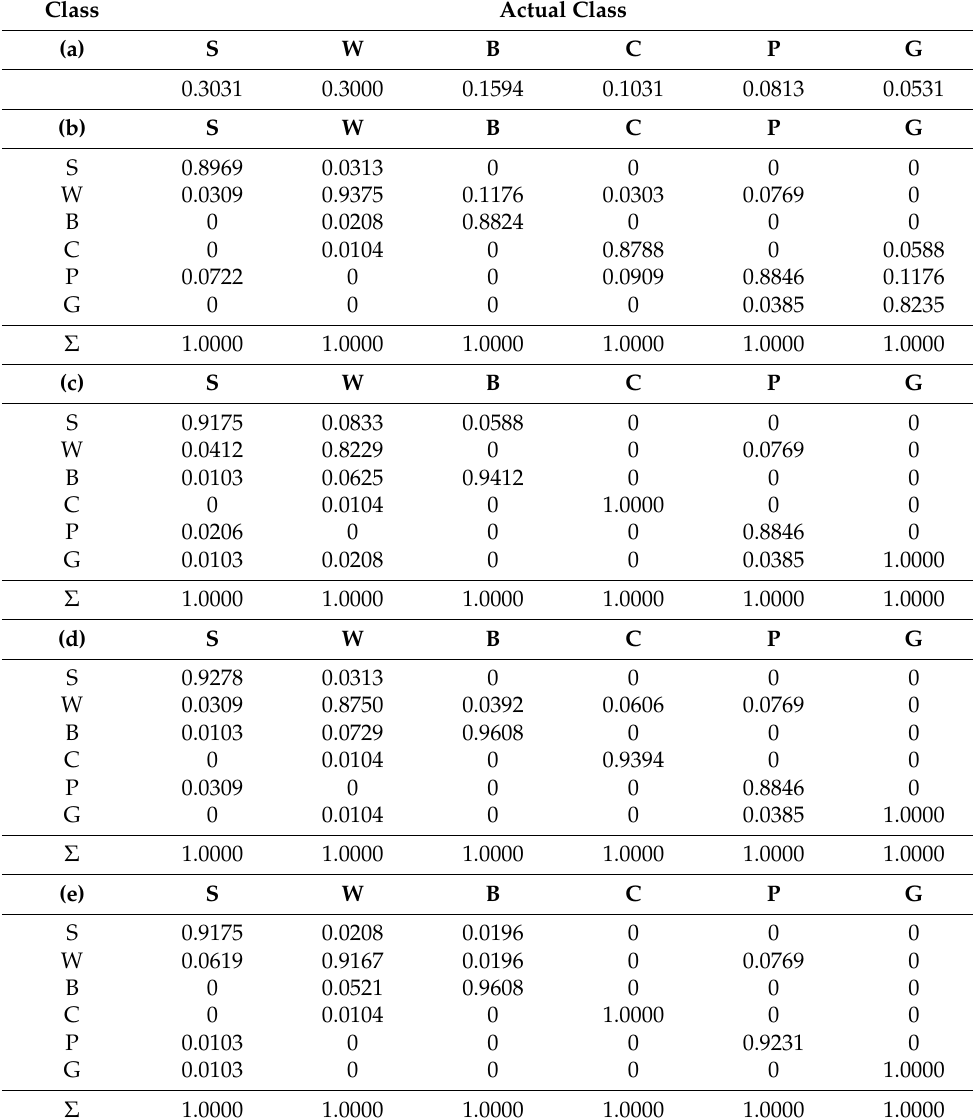
Table 2. Probabilities of class membership obtained with ground reference data; actual class of membership in columns. Values calculated as conditional to actual class of membership. ( a ) prob- ability of class occurrence, ( b ) conditional probabilities from the discriminant analysis, ( c ) condi- tional probabilities from the decision tree, ( d ) conditional probabilities from the neural network and ( e ) conditional probabilities from the support vector machine. As in Table 1, the main diagonal in ( b – e ) represents the producer’s